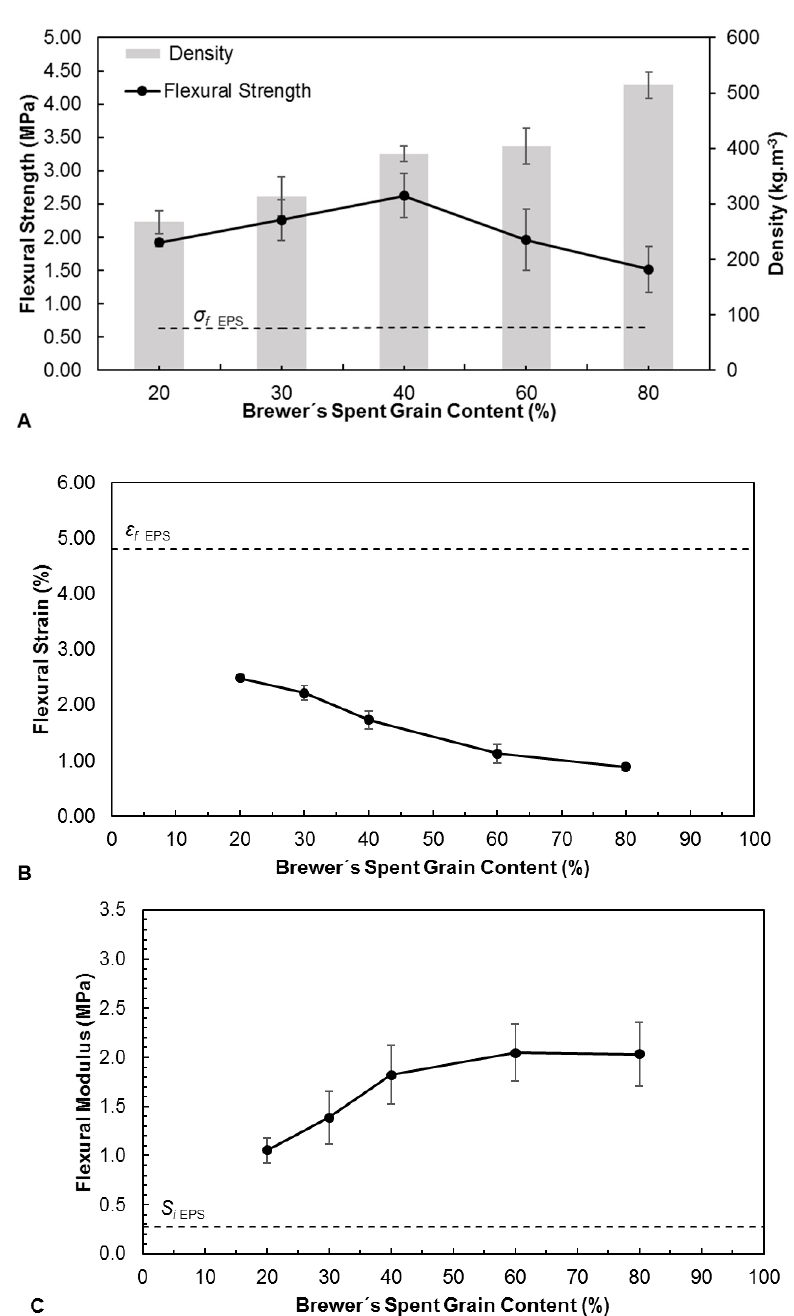
Figure 4. Flexural strength and density ( A ), flexural strain at break ( B ) and flexural modulus ( C ) of trays produced with different contents of Brewer´s Spent Grain, defined as the weight fraction in the BSG/starch dry mixture. The horizontal dashed line represents the flexural strength of expanded polystyrene (EPS) trays.